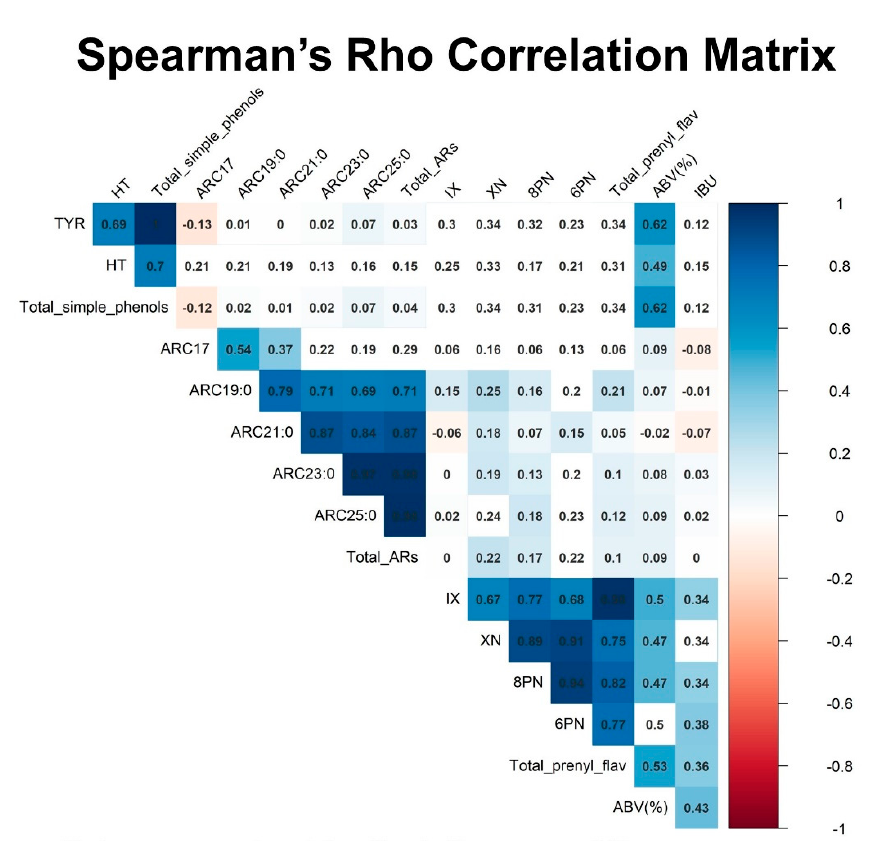
Figure 1. Spearman’s Rho correlation matrix of the studied phenolic compounds in the overall beer sample ( n = 45). Blank squares represent correlations of p > 0.05. Tyrosol (TYR). Hydroxytyrosol (HT). Sum of TYR and HT (total simple phenols). Alkylresorcinols (ARs). Sum of AR-C17:0, AR-C19:0, AR-C21:0, AR-C23:0, AR-C25:0 (total AR). Xanthohumol (XN). Isoxanthohumol (IX). 8-prenylnaringenin